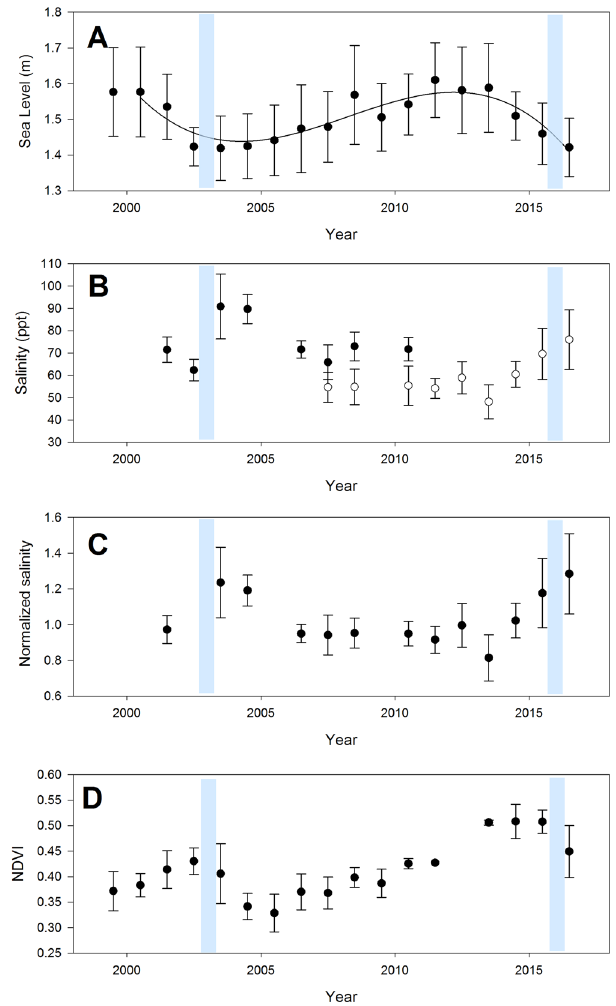
Figure 2. Inter-annual variation in mean sea level ( A ), mean soil porewater salinity of two monitoring campaigns (black and white symbols) ( B ), normalized salinity ( C ) and mean annual Normalized Difference Vegetation Index (NDVI) (D) from 1999–2016 at Mangrove Bay on the Ningaloo coast, Western Australia. Error bars are standard deviations. Salinity was normalized (expressed in relative units) to account for differences in locations of the two monitoring strategies over the study period. A value of 1 is equivalent to the initial value while 1.25 indicates a value 25% higher than the initial soil salinity. Elevated soil porewater salinity was evident in 2003 and 2004 as well as 2015 and 2016, both periods which were associated with wide spread canopy dieback (indicated by the blue bars). Source data are available in Supplementary data Table